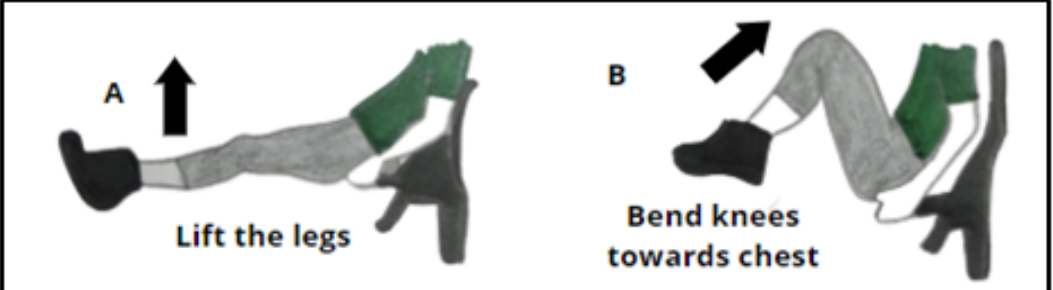
Figure-III: Illustration of performing captain’s chair